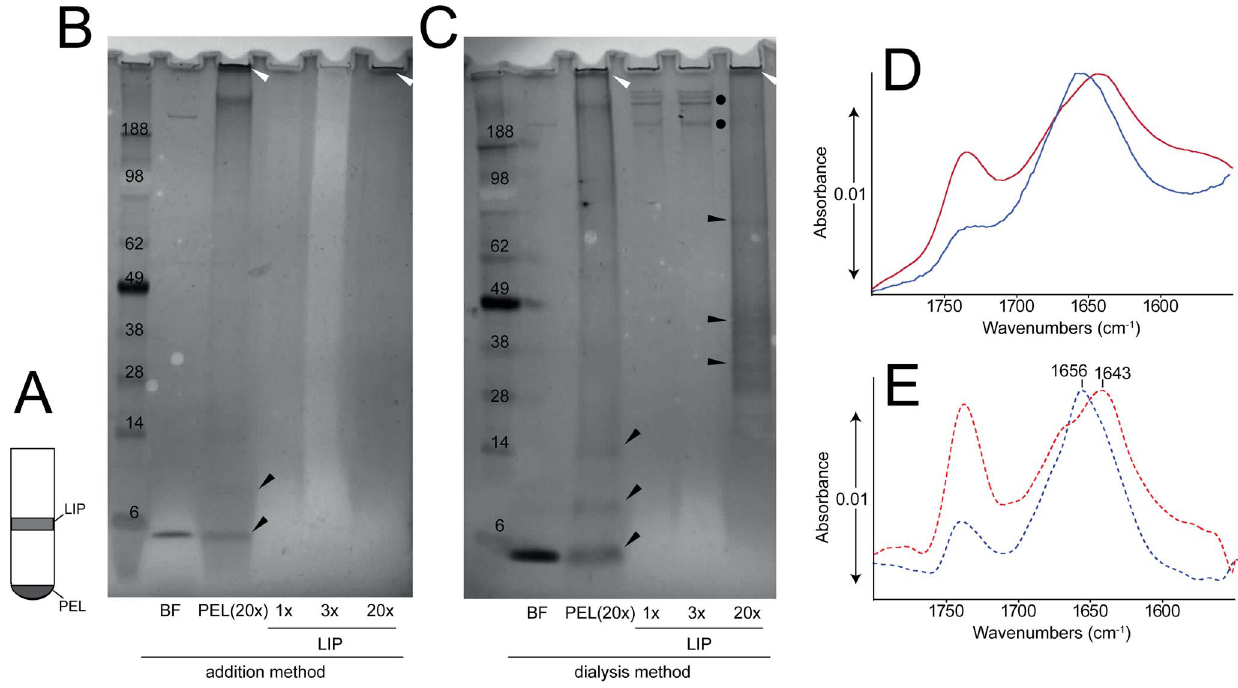
Figure 4. Incorporation of p7 into lipid bilayers. (A) Schematic representation of the flotation system, where fractions with increasing density are found: (LIP), fraction with expected liposome fraction and (PEL), the most dense fraction; (B) SDS-PAGE gel corresponding to samples in the addition experiment: (BF) sample after addition and before liposome flotation, (PEL) sample at the bottom of the tube (see A), (LIP) sample associated to liposomes (see A). Sample loading was nominally 4 m g (1 6 ) except in samples PEL and LIP, as indicated. Arrows and dots are shown for reference to indicate significant bands; (C) same as (B), but for the extruded sample where detergent was removed before extrusion; (D) ATR-IR spectra of the LIP fractions for the ‘addition’ sample (red) and the ‘extrusion’ sample (blue). Spectra for other p7 containing fractions were similar and are not shown; (E) same as (D), after a mild deconvolution (FWHH=25 cm 2 1 and k=1.5). The main maxima in the amide I region are indicated.